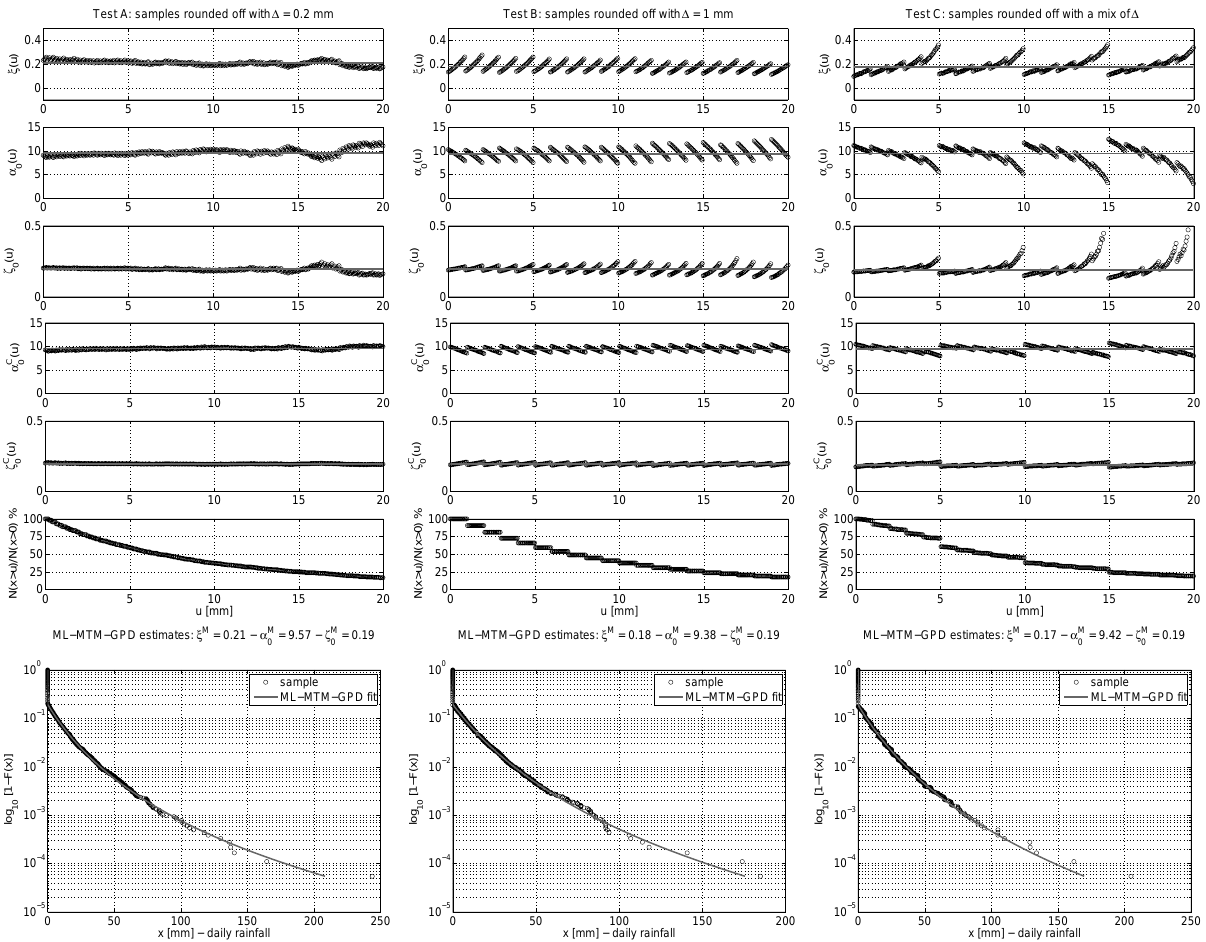
Test C: samples rounded off with a mix of Δ